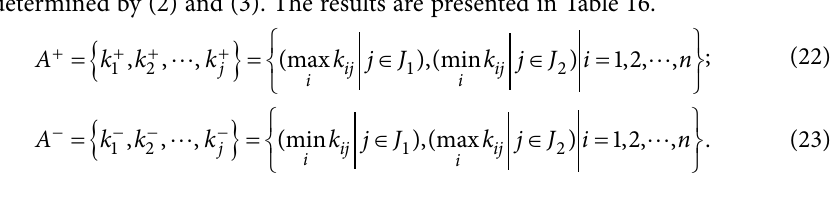
Table 16. The positive ideal solution and negative ideal solution c 1 c 2 c 3